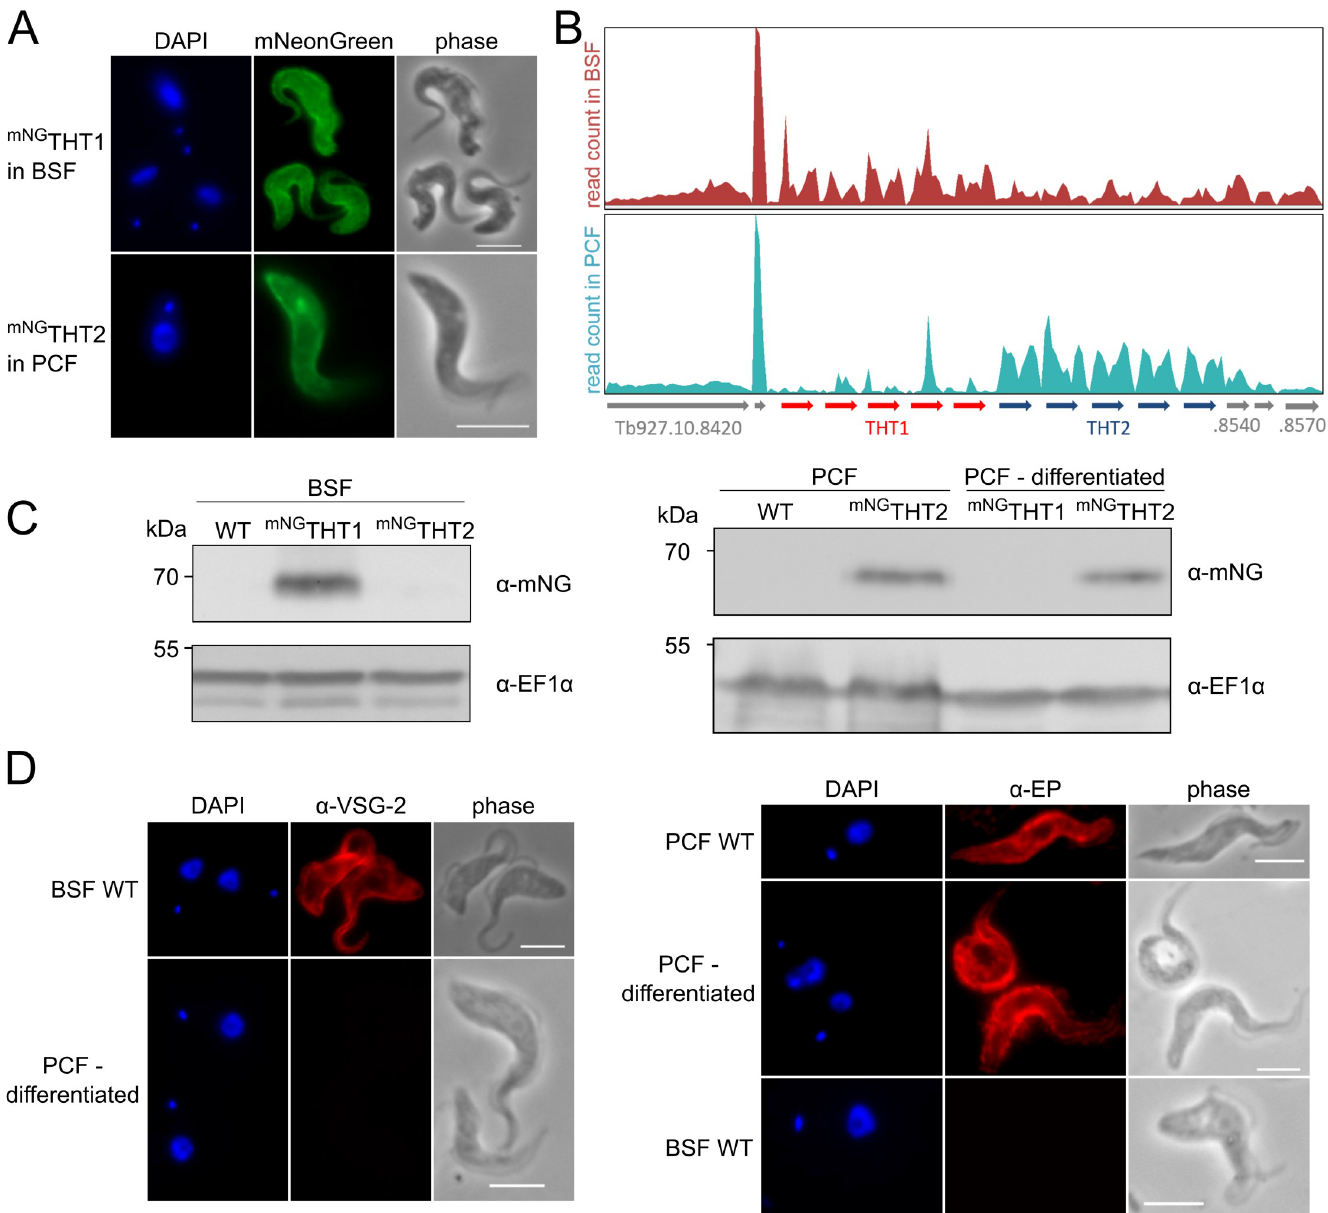
Fig 1. Glucose transporters localise to the cell surface and are developmentally regulated. (A) Fluorescence microscopy analysis. mNG THT1 and mNG THT2 localise to the cell surface in bloodstream and insect stage T . brucei , respectively, as shown by direct mNeonGreen (mNG) fluorescence. (B) Differential RNA-seq expression analysis of THT1 and THT2 genes in BSF and PCF showing developmental control. Total number of reads at the THT1/THT2 locus, applying an uniqueness filter of MapQ > 1, are depicted using the Artemis genome browser [66]; raw transcriptomic data was derived from Hutchinson et al [30]. (C) Western blot analyses indicating stage specific expression of in situ tagged mNG THT1 and mNG THT2 in BSF (left) and PCF and cells differentiated in DTM medium (right). WT, wild-type; EF1 α serves as a loading control. (D) Differentiation in DTM medium of mNG THT expressing cells ( mNG THT2 cells shown) was validated by immunofluorescence microscopy with stage specific surface markers, VSG-2 for BSF and EP procyclin for PCF. In A and D, DNA was counter stained with DAPI; Scale bars 5 μ m.